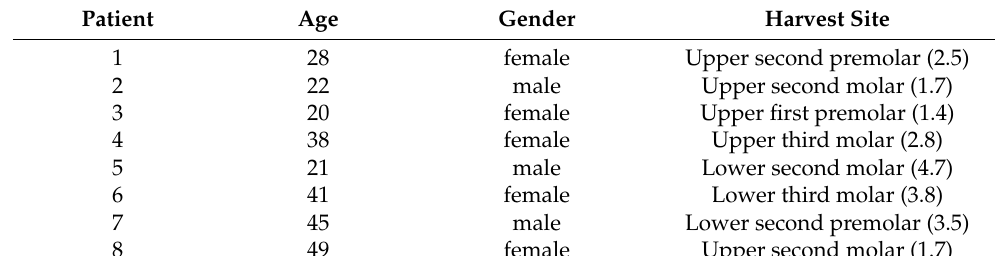
Table 3. Characteristics of the study group.